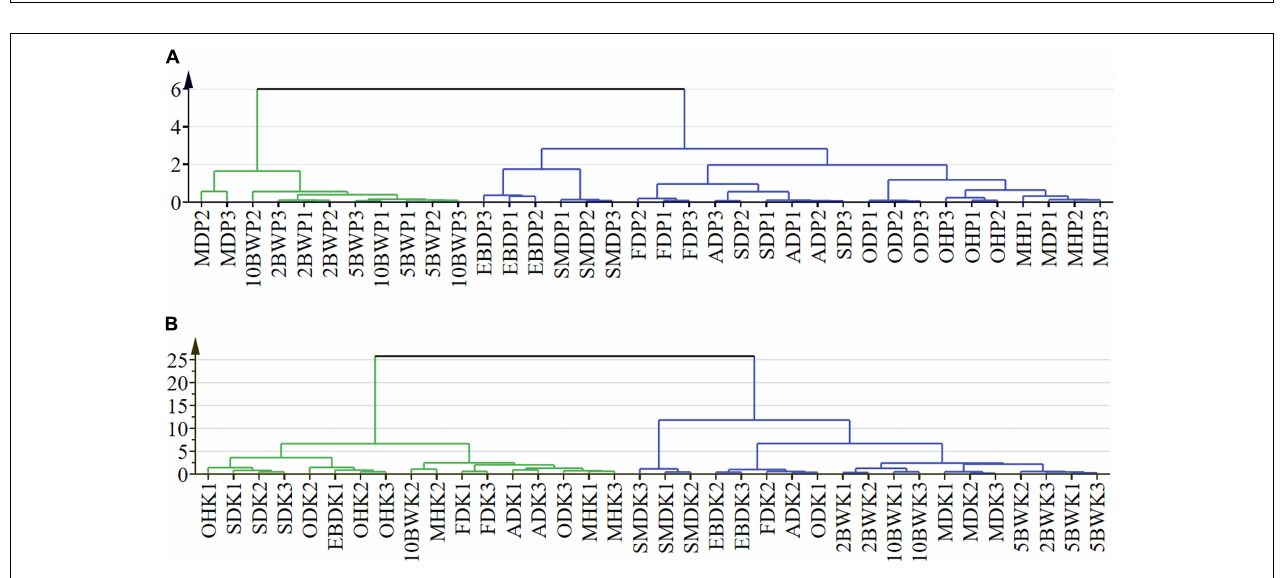
FIGURE 5 | Cluster analysis of pre-drying and drying methods in the pericarp (A) and kernel (B) of A. tsao-ko .